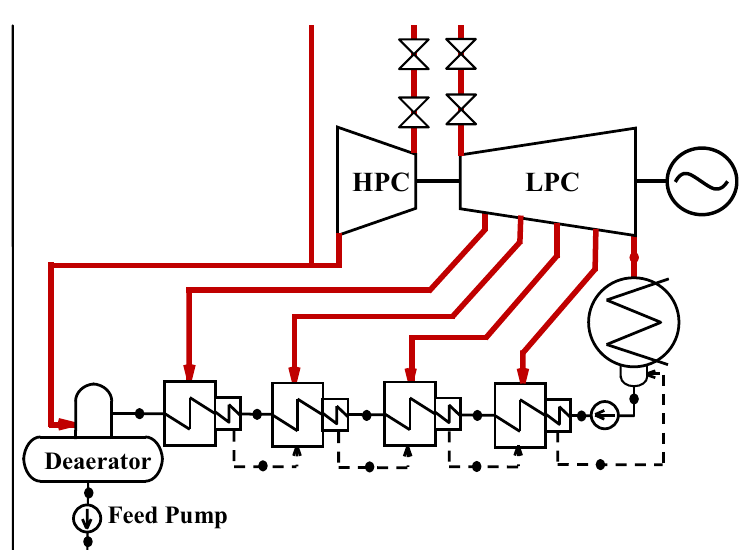
Fig. 2. Advanced regenerative preheating Rankine-Hirn cycle diagram